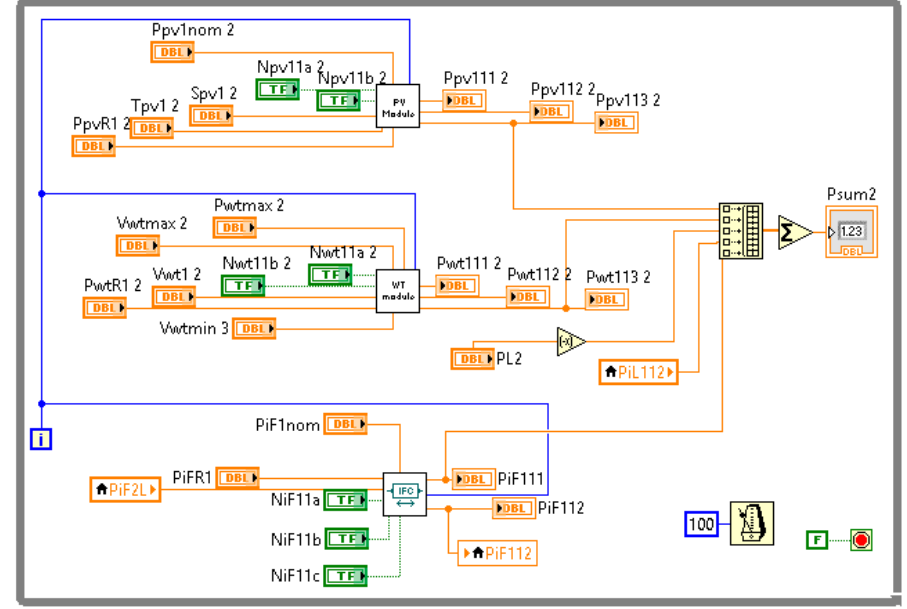
Figure 16. LabVIEW programming for DC bus 2.